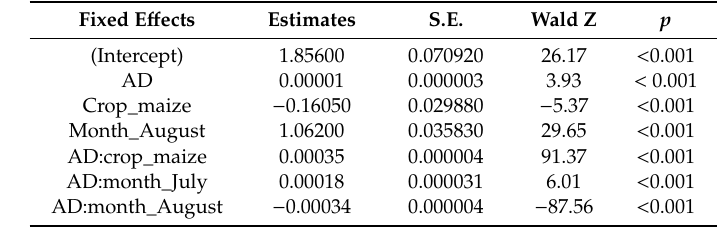
Table 1. Generalized linear mixed models (GLMMs) related ladybeetle metapopulation density (LMD) with aphid density (AD) on cotton and maize crops in different months at the regional landscape scale.The fixed effects included AD, crop, month, and interactions of different explanatory variables. Estimates and S.E. was the coefficient and standard error of the fixed effect. The bold p value indicates a significant effect ( p < 0.05).